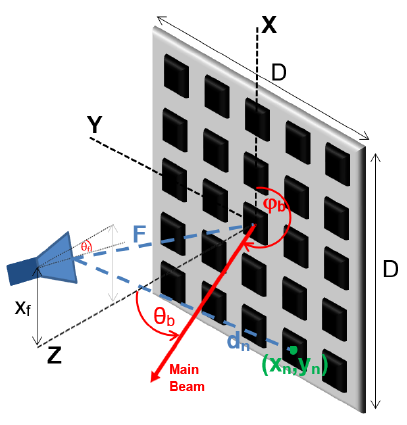
Figure 2. Main geometrical parameters of a reflectarray